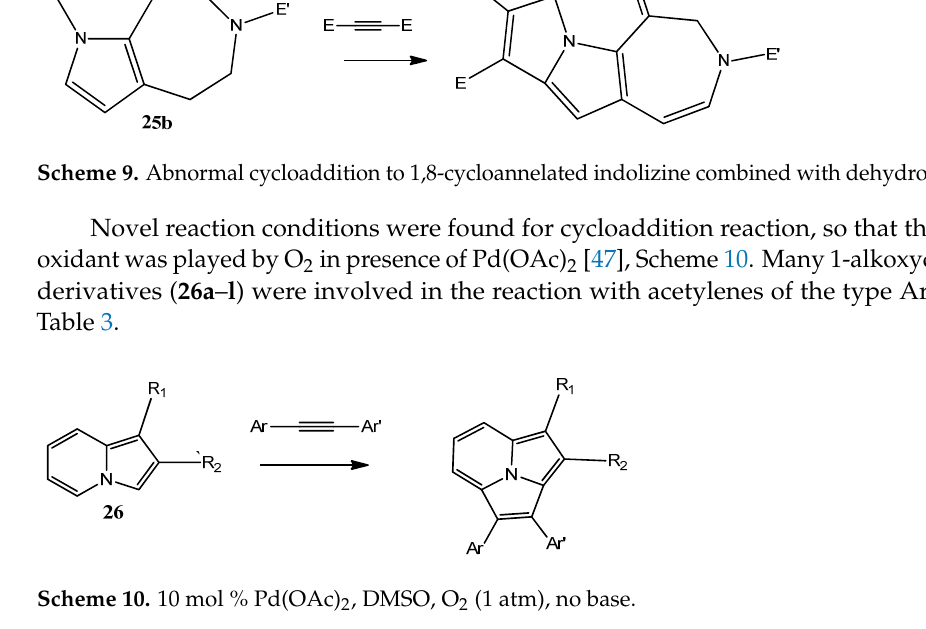
Table 3. Substituents and yields of cycloaddition of diarylalkynes to indolizines (Scheme 10). N R R’ R1 R2 Yield % Ref.